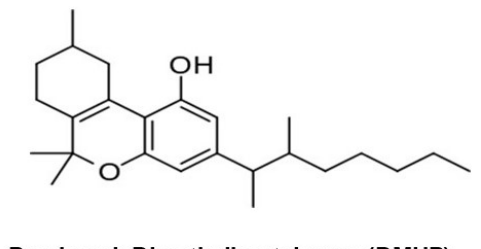
Figure 7. Structure of pyrahexyl (DMHP).